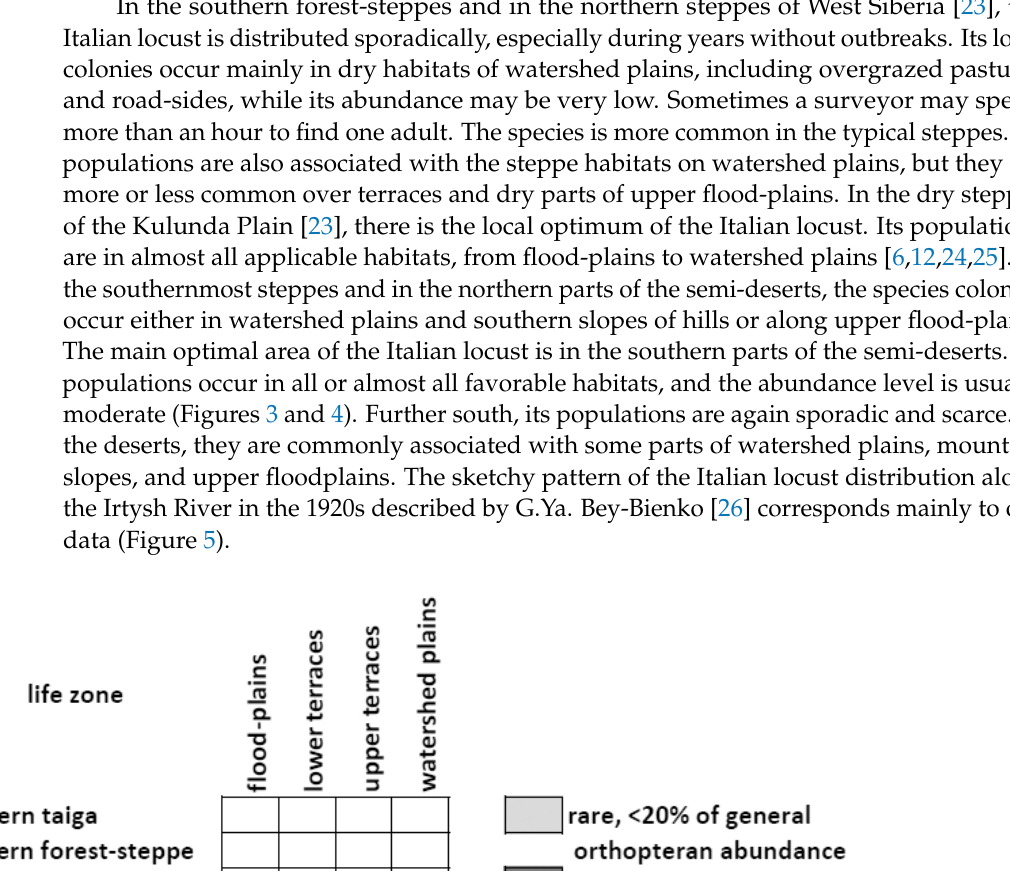
Figure 4. Population distribution of the Italian locust along two gradient (transzonal) transects crossing the south-eastern part of West Siberian Plain and the adjacent north-eastern and eastern parts of the Kazakh Uplands along the Irtysh River ( A ) and near the 80th meridian east ( B ). N— north; E—east.